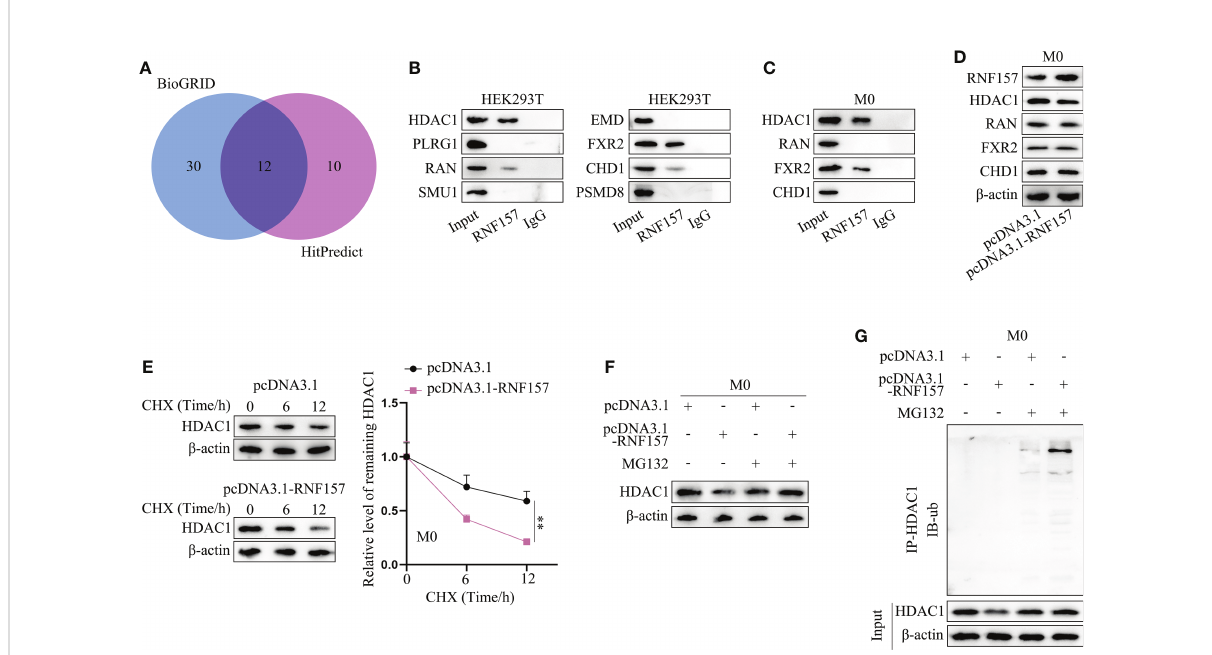
FIGURE 4 RNF157 facilitated HDAC1 ubiquitination and degradation in macrophages. (A) Proteins with binding potential to RNF157 were predicted on BioGRID and HitPredict. (B) CoIP analyzed the cohesion between RNF157 protein and the candidates in HEK293T. (C) CoIP detected the binding between candidates and RNF157 proteins in macrophages. (D) The expression of candidate proteins was analyzed by western blot in macrophages with or without RNF157 elevation. (E) The level of HDAC1 in macrophages at different time points after CHX treatment was measured through western blot. (F) The protein levels of HDAC1 were tested by western blot in macrophages under MG132 treatment when RNF157 was up-regulated or not. (G) Ubiquitination of HDAC1 in macrophages with or without RNF157 overexpression was analyzed via IP-WB. **P <